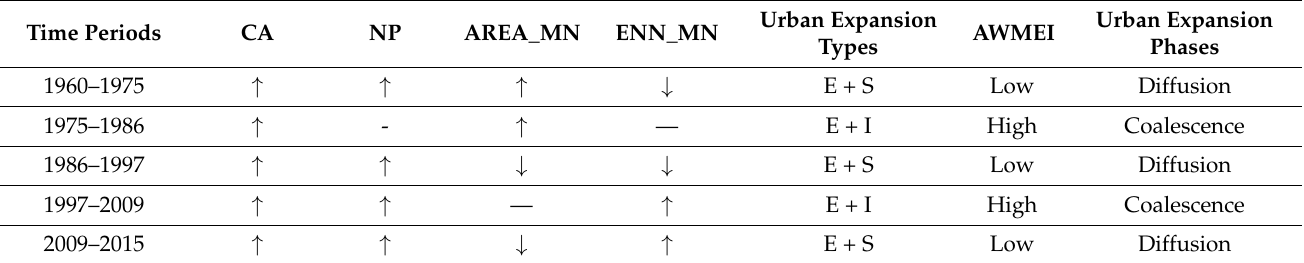
Table 6. Summary of the temporal dynamics of landscape metrics, urban growth types, and their abundance and urban expansion phases. ↑ , ↓ , and — indicate increase, decrease, and relatively stable, respectively. E, S, and I represent edge-expansion, spontaneous growth, and infilling,